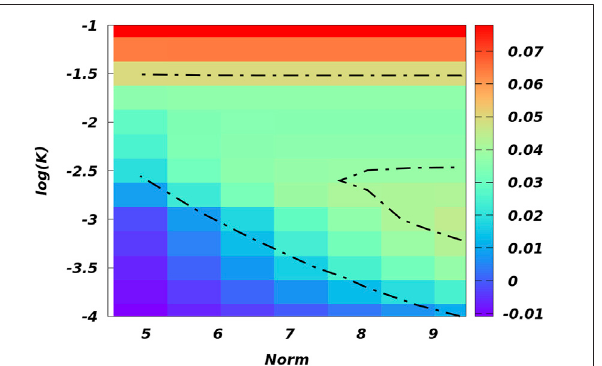
FIGURE 11 | (Color online) The contour plot described the energy variation asafunction oftrap frequency (in logscale) and norm (norm = clearly illustrates the phase boundaries between the droplet-like state (bluish section,mainlybottomandbottomleft),soliton-likestate(reddishregion, in the top), and an intermediate droplet-soliton mixture (greenish region, in the